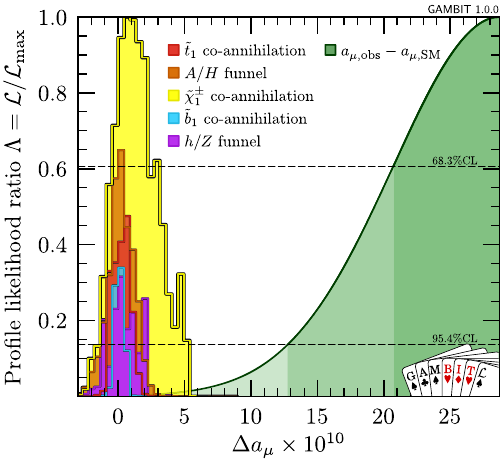
Fig. 6 1DprofilelikelihoodratiofortheSUSYcontribution (cid:10) a μ tothe anomalousmagneticmomentofthemuon.IngreenweshowaGaussian likelihoodfortheobservedvalue a μ, obs − a μ, SM = ( 28 . 7 ± 8 . 0 ) × 10 − 10 , where we have combined the experimental and Standard Model (SM) theoretical uncertainties in